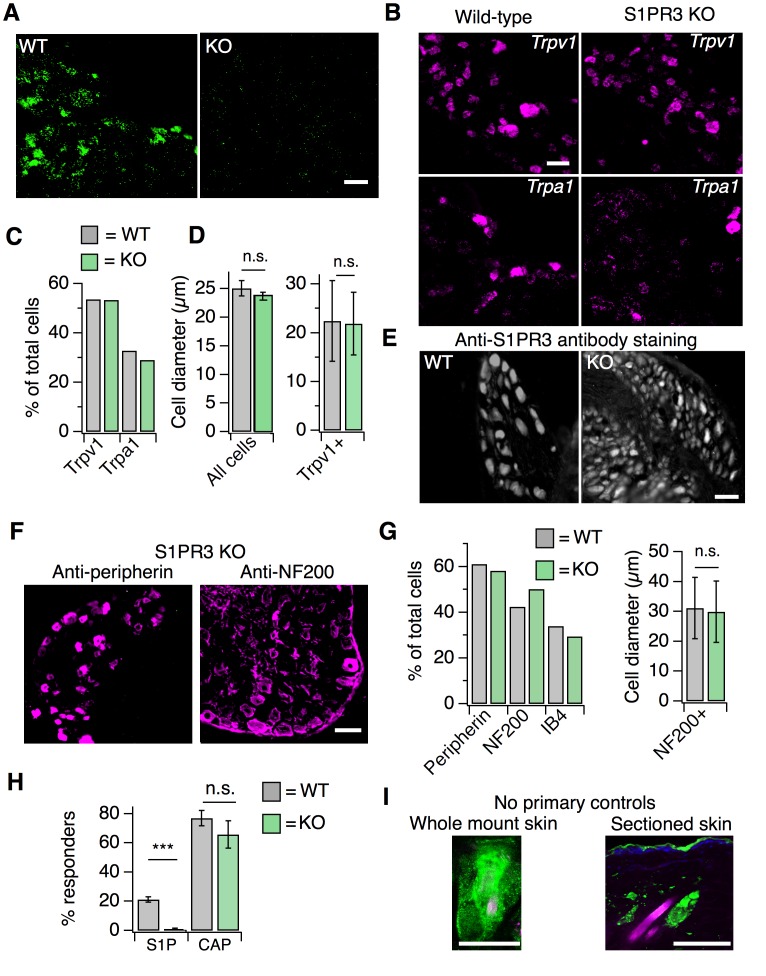
S1PR3 KO animals display normal representation of somatosensory neuronal subtypes.Related to Figure 3. (A) ISH of sectioned adult DRG from WT and S1PR3 KO animals showing specificity of S1pr3 probes (20x air objective, scale = 50 µm). (B) (Image) Representative ISH Trpv1 (top) and Trpa1 (bottom) from sectioned DRG of wild-type (left) and S1PR3 KO animals (right; 20x air objective; scale = 50 µm). (C) % of total cells expressing Trpv1 and Trpa1 in sectioned DRG of wild-type and S1PR3 KO animals. (D) (Left) Average diameter ± SEM of all cells in sectioned DRG from WT and S1PR3 KO animals (p=0.36, two-tailed t-test; n = 437 and 679 cells from two animals each, respectively). (Right) Average diameter ±SD of Trpv1+ cells in WT and S1PR3 KO DRG (p=0.63, two-tailed t-test; n = 127 and 85 cells, respectively). (E) Representative staining with anti-S1PR3 antibody (1:2000) in sectioned adult DRG from WT and S1PR3 KO animals (10x air objective, scale = 100 µm). (F) Representative IHC images of sectioned DRG from S1PR3 KO animals stained with anti-DsRed (green) and anti-Peripherin (left, magenta) or anti-NF200 (right, magenta). Images were acquired using a 10x air objective (scale = 100 µm). (G) (Left) Quantification of total percentage of cells stained with indicated markers in sectioned DRG from S1pr3mCherry/+ and S1PR3 KO animals (n > 250 cells per condition). (Right) Average diameter of anti-NF200 +cells in S1pr3mCherry/+ and S1PR3 KO DRG (p=0.15, two-tailed t-test; n = 256 and 194 cells, respectively). (H) Percent responders to S1P and capsaicin in ratiometric calcium imaging of wild-type and S1PR3 KO cultured DRG and TG neurons; p<0.0001 (one-way ANOVA; N = 2 DRG and 2 TG preparations of 8 wells each). Sidak’s multiple comparisons p-values are represented on graph for comparisons made between genotypes. Error bars represent mean ± SEM. (I) (Left) No primary control showing robust staining of hair follicles in whole mount skin in contrast to specific neuronal staining shown in Figure 3D. (Right) No primary control showing staining around hair follicles and in epidermis in sectioned skin. Scale = 50 µm (20x water objective).